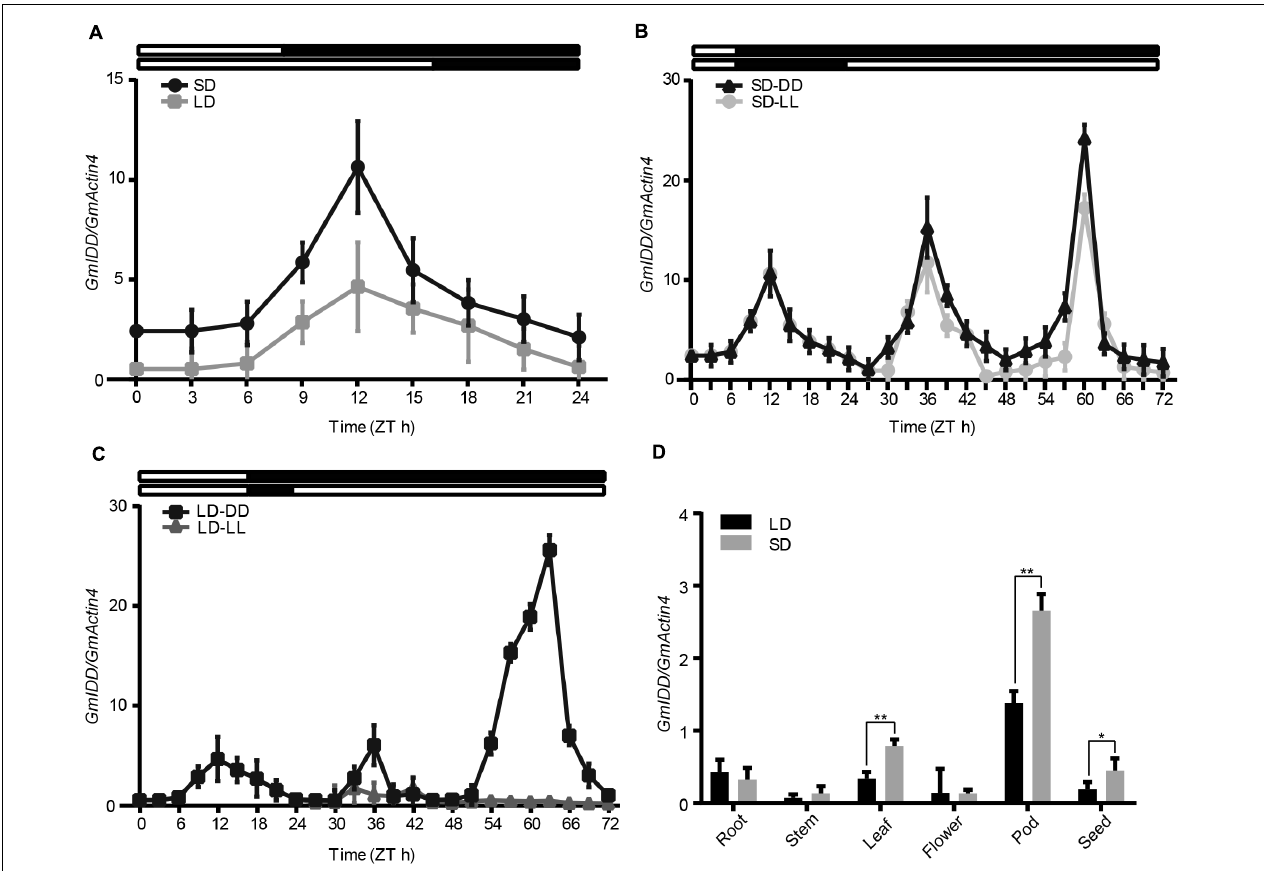
FIGURE 2 | qRT-PCR analyses of soybean GmIDD expression patterns. (A–C) Soybean “Dongnong 42” plants, which were grown in LDs (16 h/8 h light/dark) for 15 days, were transferred to LDs or SDs (8 h/16 h light/dark) for 15 days for sampling. Trifoliate leaves were sampled at 3 h intervals. (A) GmIDD diurnal expression under SDs and LDs. (B) Expression patterns of GmIDD transcripts under constant darkness (DD) and constant light (LL) conditions from SDs. (C) Expression patterns of GmIDD transcripts under constant darkness (DD) and constant light (LL) conditions from LDs. White and black bars at the top represented light and dark phases, respectively. (D) Tissue-specific expression of GmIDD at 12 h after dawn under SDs and LDs. All the data were normalized with soybean GmActin4 gene as internal reference. For each experiment, three technical replicates were conducted. Data shown are mean ± SD of three independent experiments. Significant difference between the expression level of GmIDD under SDs and LDs was indicated by asterisk (* P < 0.05 and ** P < 0.01, Student’s t